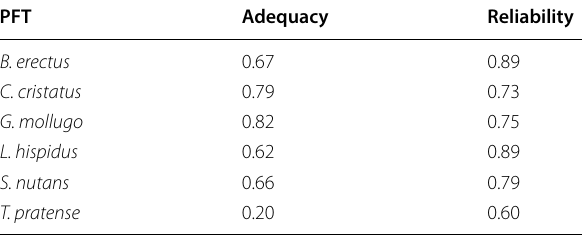
Table 5 Model adequacy and reliability values for the predicted control communities